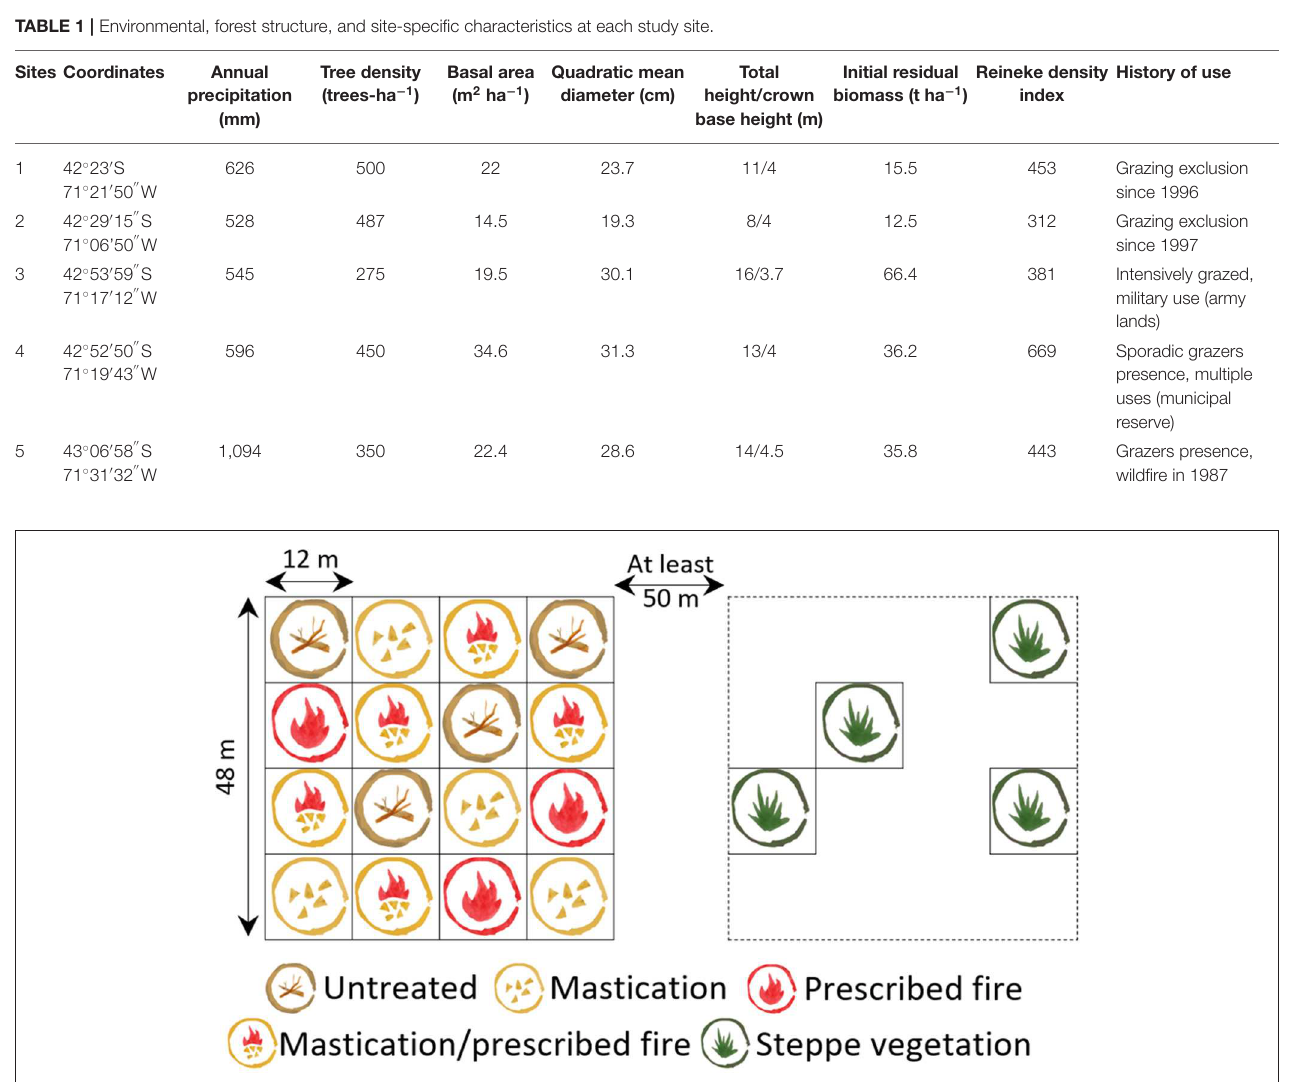
FIGURE 2 | Original design scheme representing four replicates per fuel treatment within the plantation on the left, and four replicates per steppe vegetation on the right.